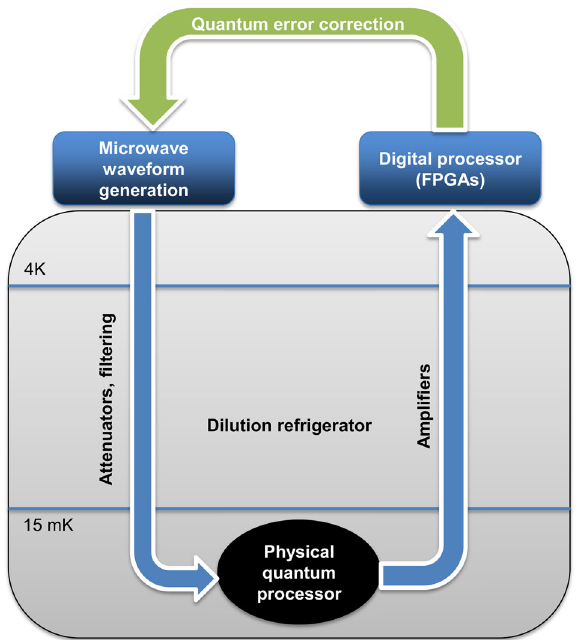
Fig. 2 The physical qubit processor is located at the bottom (15 mK) plate of a dilution refrigerator. Microwave pulses are generated at room temperature using synthesizers, arbitrary waveform genera- tors, and mixers. These pulses are fi ltered and attenuated to assure negligible noise at the qubit. High- fi delity readout of the qubit state requires quantum-limited and other cryogenic ampli fi cation to overcome thermal noise for digitization and weighted homodyne measurement. 33 The QEC processor sits above and orchestrates the physical control and readout functions, to perform the error correction